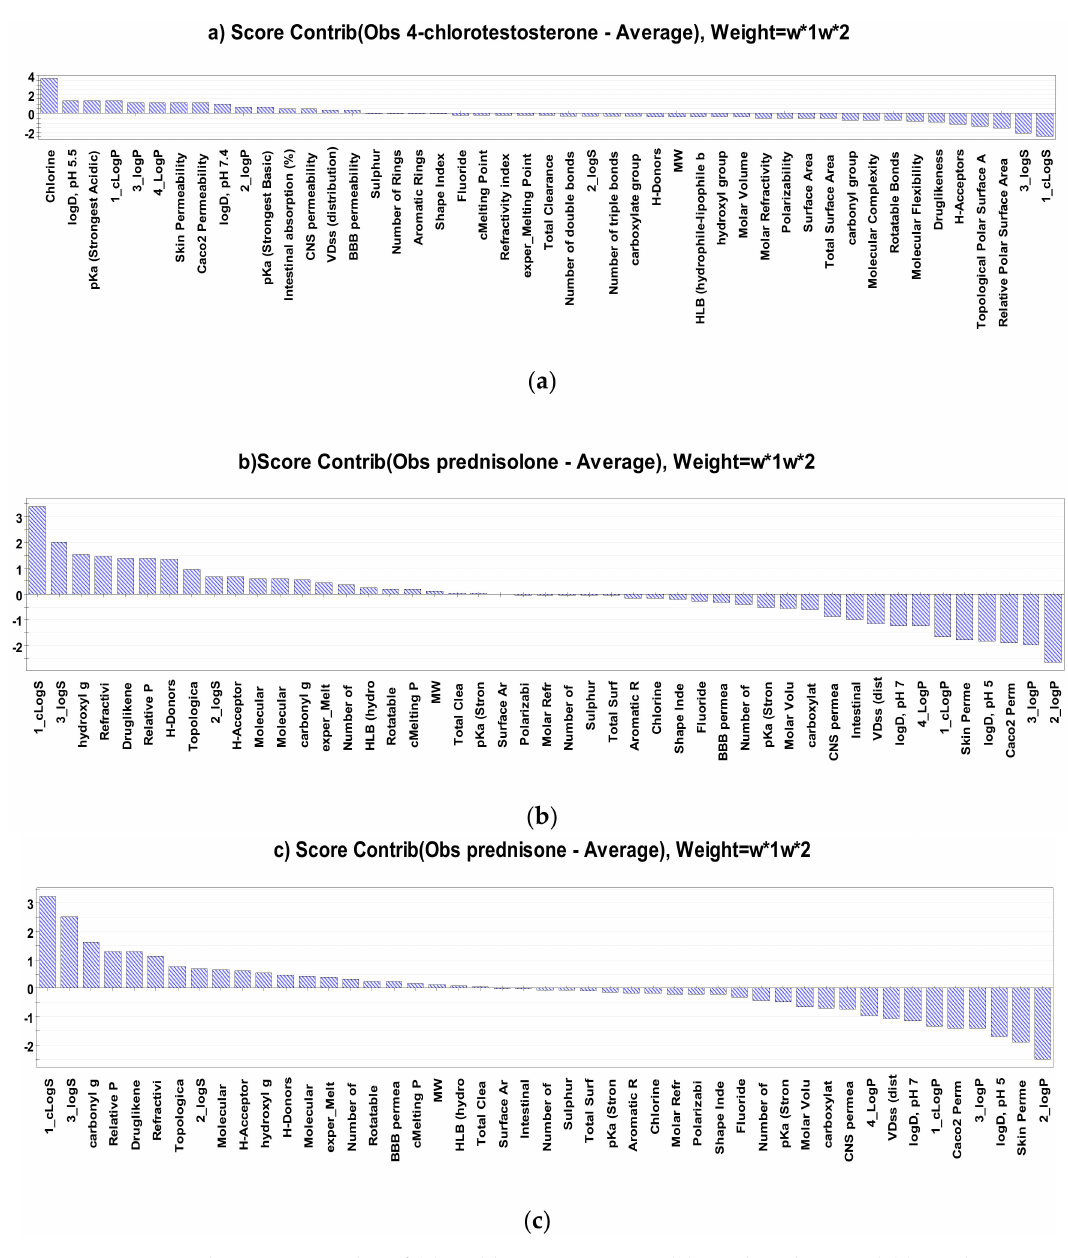
Figure 5. Contribution score plot of ( a ) 4-chlorotestosterone, ( b ) prednisolone and ( c ) prednisone, versus the remaining